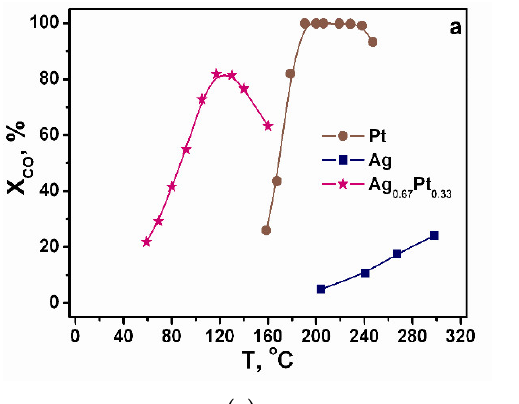
Figure 10. The temperature dependences of CO conversion (X CO ) for CO TOX over the Pt, Ag, and Ag 0.67 Pt 0.33 nano-powders. Feed gas composition (vol.%): 1.0 CO, 1.0 O 2 with He as balance. WHSV: 80 000 cm 3 g −1 h −1 (STP).